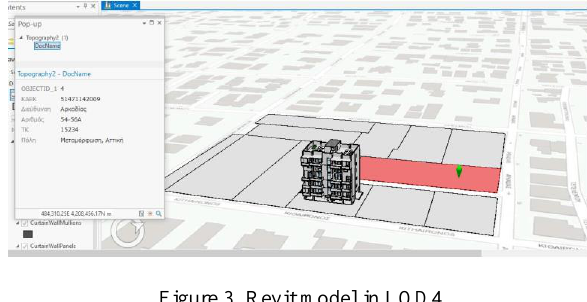
Figure 3. Revit model in LOD4 Source: Result of processing in ArcGIS Pro v.2.2.